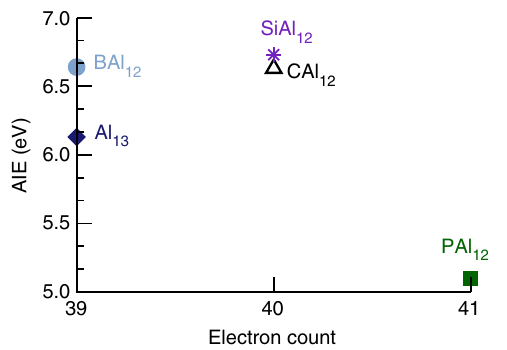
Fig. 2 Electronic properties of ligand-free Al and doped Al clusters. Adiabatic ionization energies of bare Al 13 , MAl 12 (M = B, C, Si, and P) clusters. All the values are given in eV Supplementary Fig. 1. In Al 13 (EP) 3 , SiAl 12 (EP) 3 , and PAl 12 (EP) 3 , the 3rd ligand stabilized in an ortho position, while it is the meta position for BAl 12 (EP) 3 and CAl 12 (EP) 3 . Total energies of the optimized structures with various positioning of the ligands are given in Supplementary Figs. 1 – 3. As expected, the successive